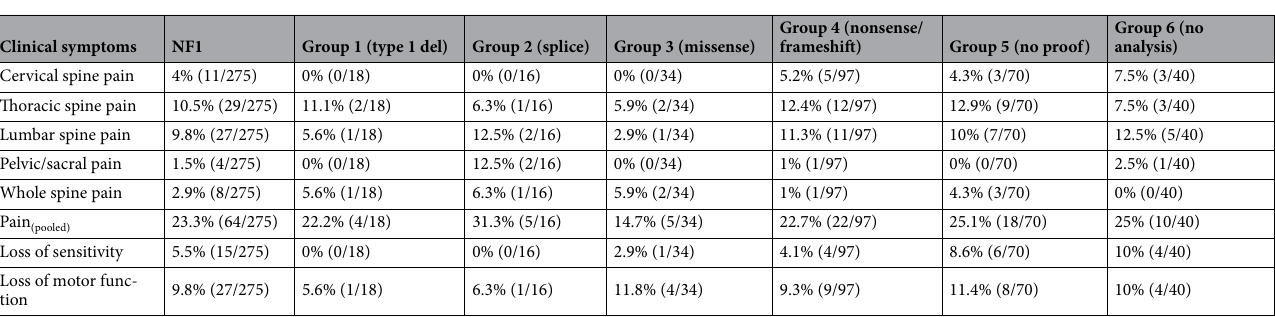
Table 4. Prevalence of clinical symptoms in NF1 patients and type of mutation of the NF1 gene.